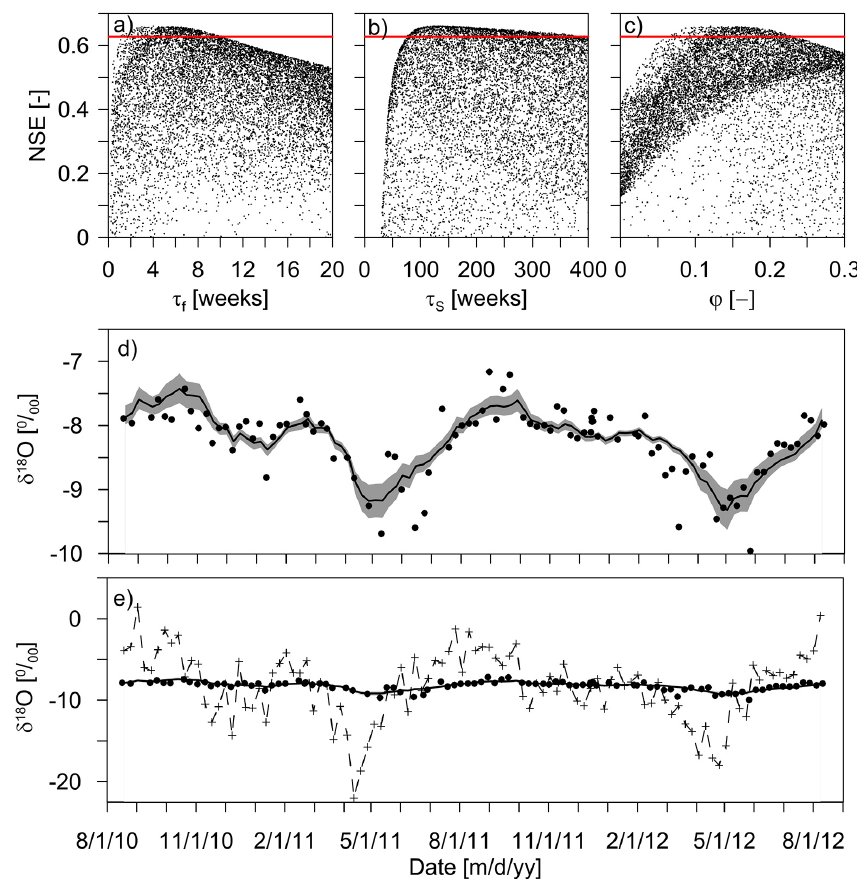
Fig. 11. Uncertainty ranges for outlet stream water (PL site) using a TPLR distribution function. (a) , (b) and (c) show the modeled parameter uncertainties of 10000 random simulations and the feasible range of behavioral solutions taking a lower limit of 5% from the best solution. Black filled circles in (d) and (e) represent the observed data; the black line and shaded area depict the best possible solution and its range of variation according to the 5–95% confidence limits of the behavioral solutions shown in (b) ; and the gray dashed line with crosses in (e) represents the weekly rainfall variation as an input function for the